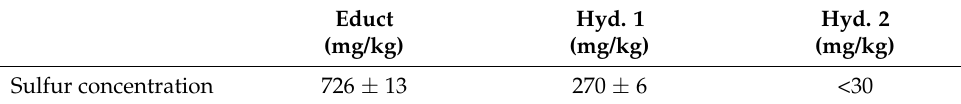
The overall product composition is depicted in Figure 6. The hydrogenation steps barely change the composition, only after the second step, a slight decrease in heavy residue can be detected, which is due to cracking reactions during hydrogenation. The loss of naphtha after Hyd. 2 is most likely due to the higher distillation loss that occurred in this case. However, the hydroprocessing reactions had a pronounced effect on product composition, with the amount of naphtha and light gases increasing rapidly with reaction temperature, while the amount of heavy residue and middle distillate was decreasing. It is interesting to note that the sum of naphtha and middle distillate stayed around 60 wt% of the feed regardless of the applied upgrading step.